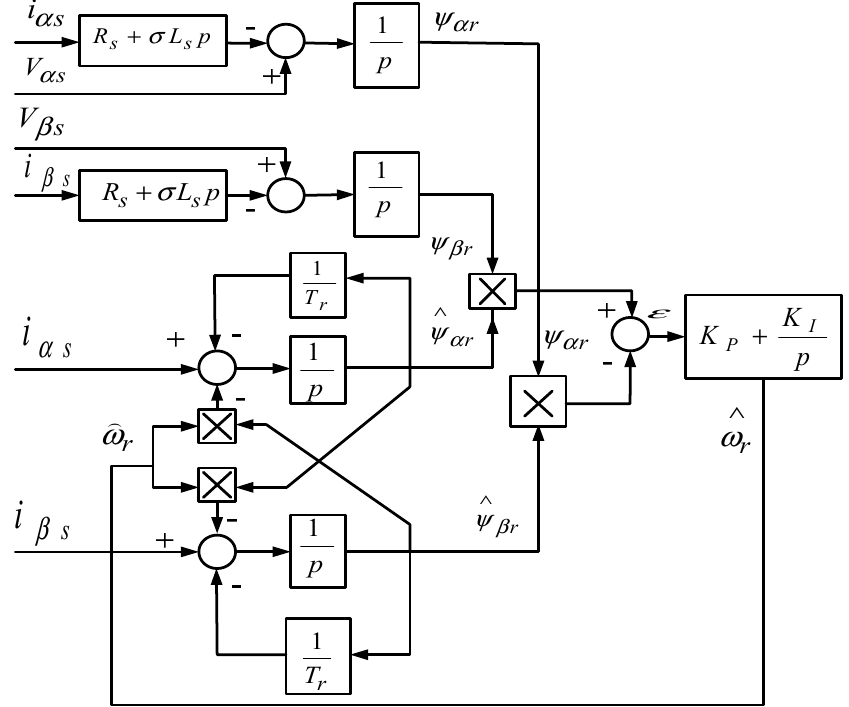
Figure 7. Block diagram of the Model Reference Adaptive System (MRAS) speed estimation system.